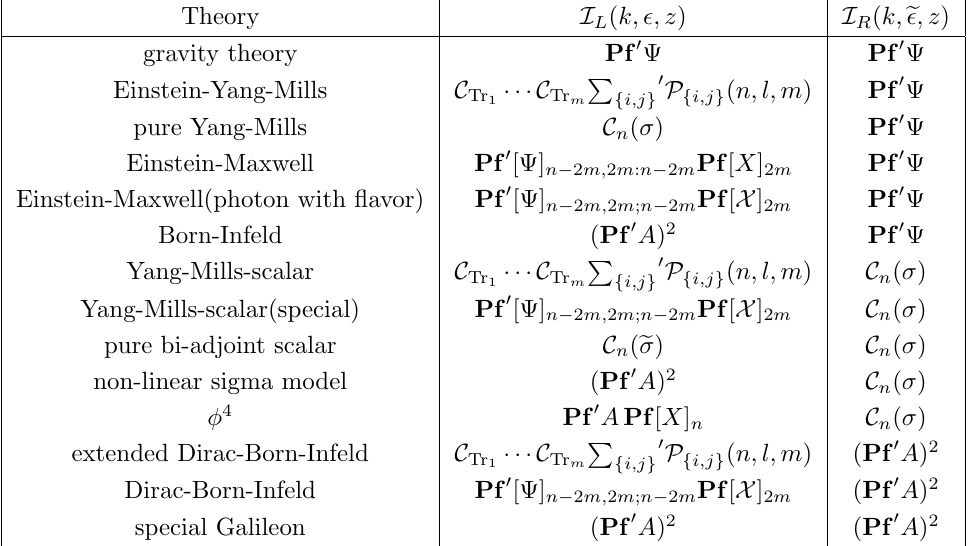
Table 1 . Form of the integrands for various